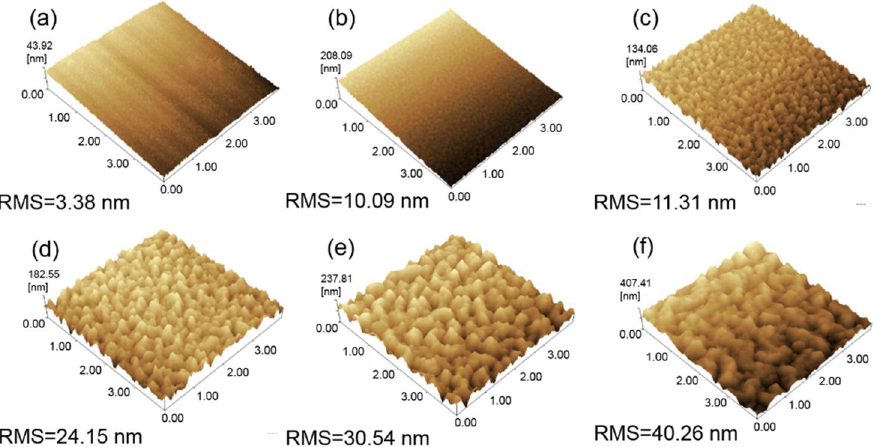
Figure 8. AFM images of the ITO/AgIn/ITO films at different spu(cid:308)ering temperatures. ( a ) 25 °C, ( b ) ◦ C, ( c ) 150 ◦ C, ( d ) 200 ◦ C, ( e ) 250 ◦ C and ( f ) 300 ◦ C, 100 °C, ( c ) 150 °C, ( d ) 200 °C, ( e ) 250 °C and ( f ) 300 °C, respectively. ( b ) 100